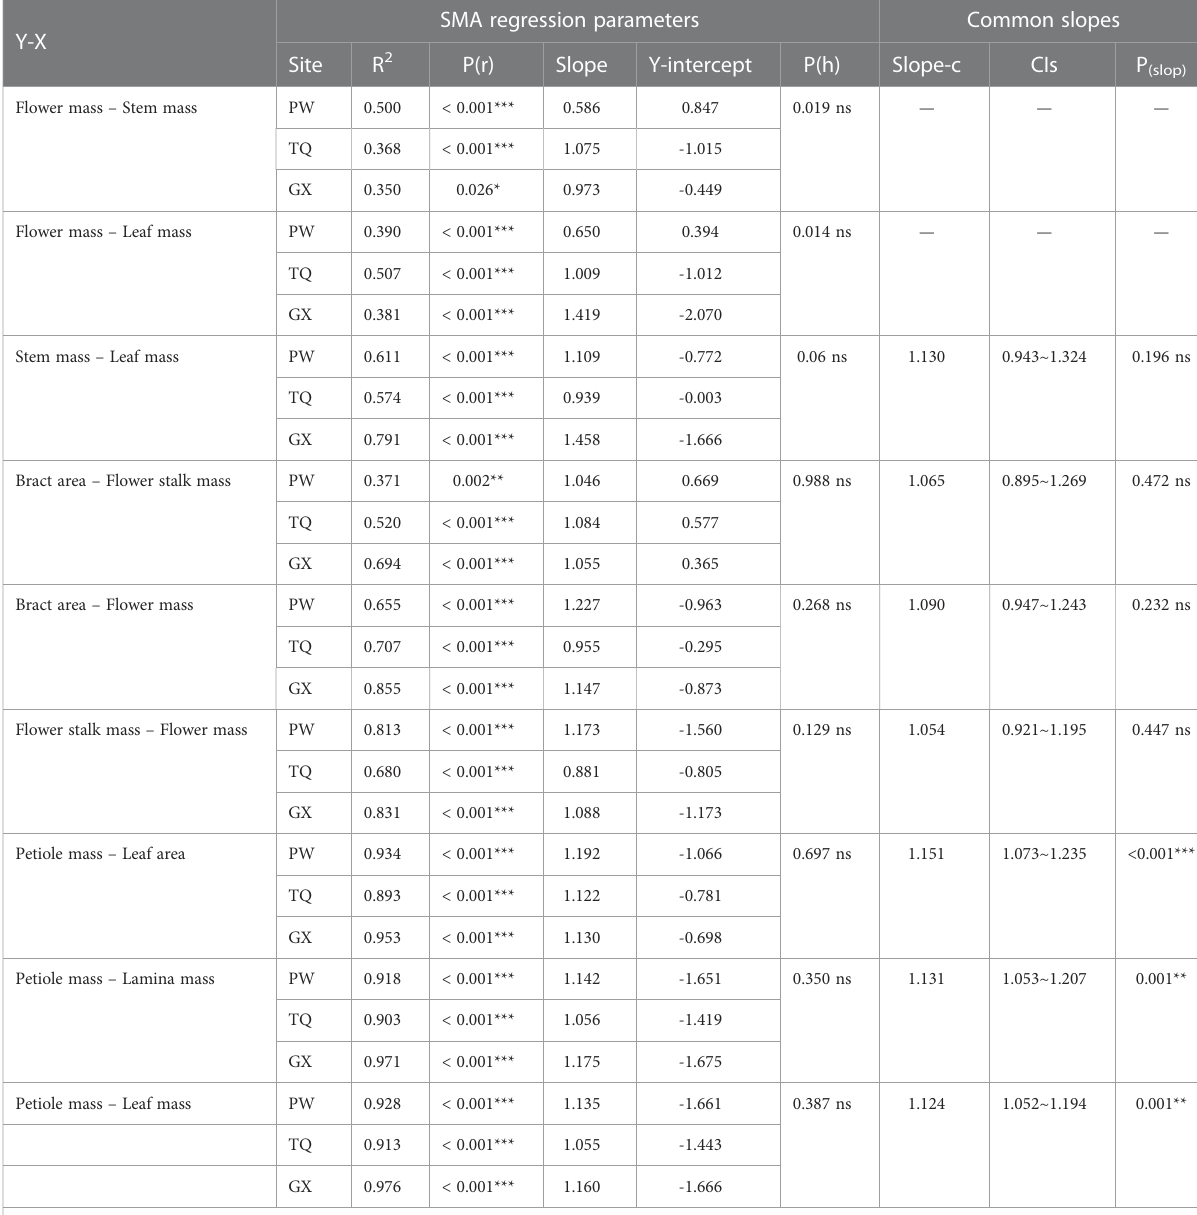
R 2 represents the correlation coef fi cients between traits, P(r) represents the level of signi fi cance testing for relationship between traits, Slope represents the allometric growth slope between traits, y-intercept represents the intercept of y axial, P(h) represents the heterogeneity of slope, Slope-c represents the common slope, CIs represents the 95% con fi dence intervals, P (slop) represents the level of signi fi cance testing for common slope. PW, Pingwu, n = 24; TQ, Tianquan, n = 30; GX, Gongxian, n = 14. The signi fi cance values of analyses are denoted as: ns, not signi fi cant; * P < 0.05, ** P < 0.01, and *** P < 0.001. Y-X represents the Y-axis and the X-axis,